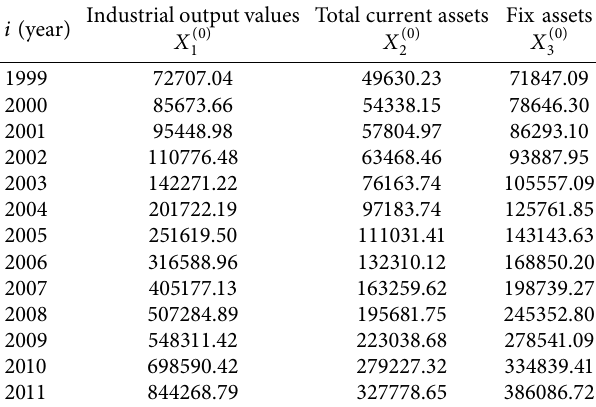
Table 4: Original data in case two (unit: 10 4 yuan)